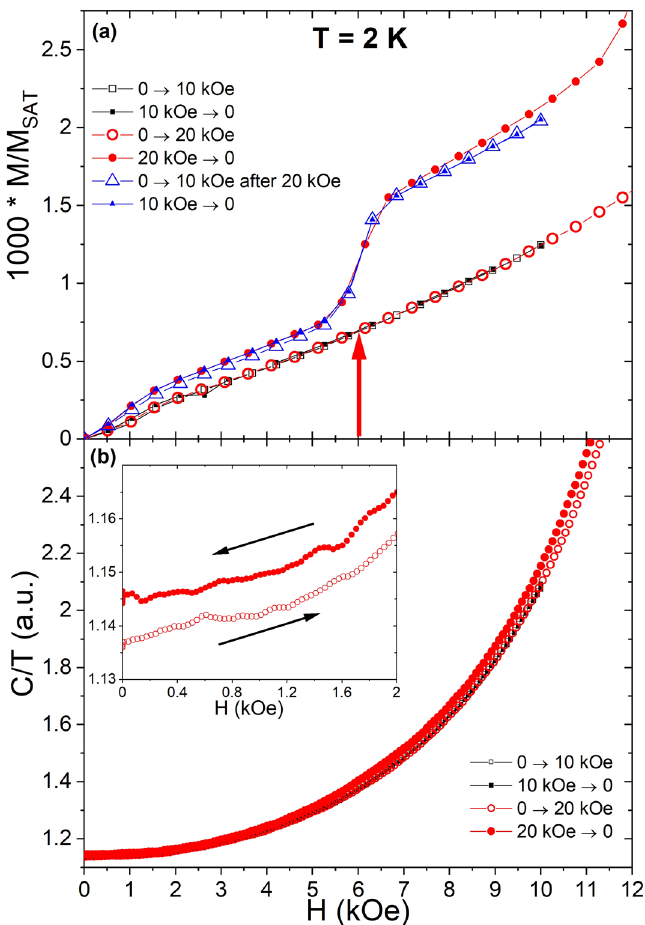
Figure 3. History dependence of the pristine low-field AF Néel phase after magnetizing the system up (and down) to 10 kOe and to 20 kOe in M ( H ) ( a ) and C/T ( b ). The observed change (jump) of magnetization corresponds to ~ 1/1000 M sat